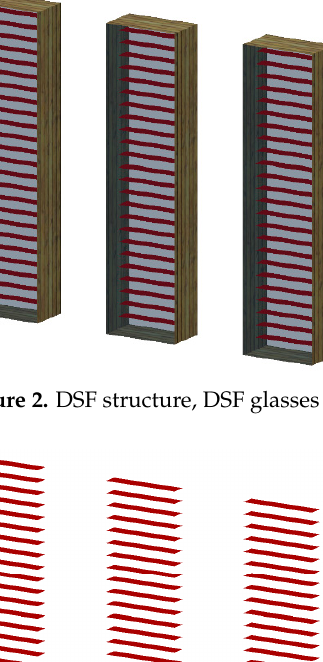
Figure 1. Compartment, double skin facade (DSF) structure, DSF glasses and Venetian-type blinds.